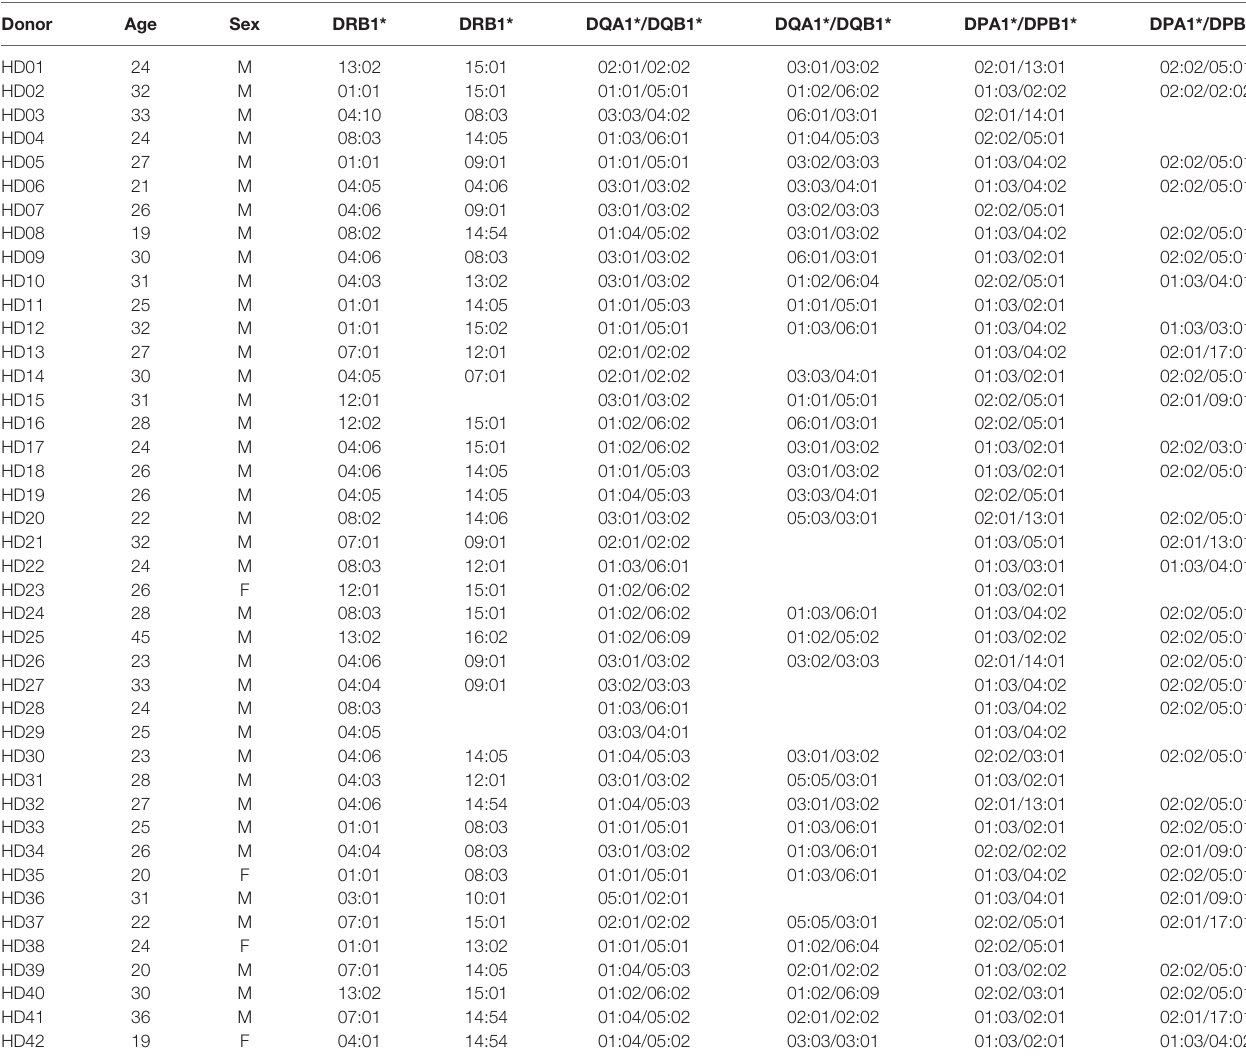
TABLE 1 | Genotypes of HLA class II in 42 healthy